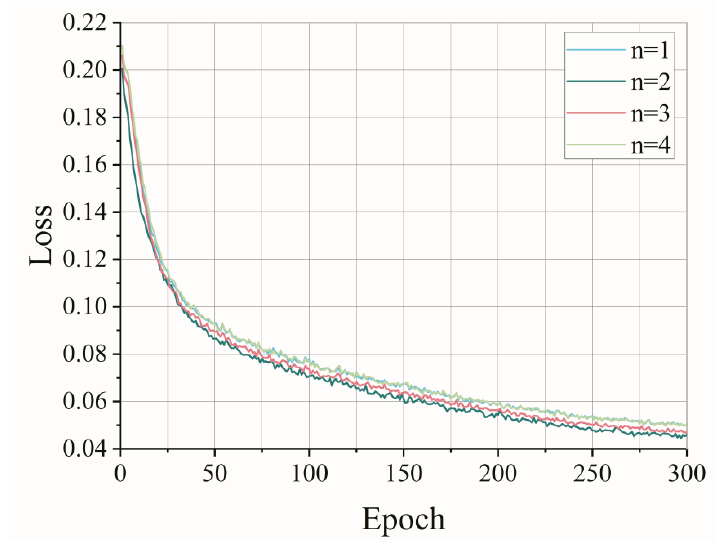
Figure 8. Loss curve with the number of RPM paste.